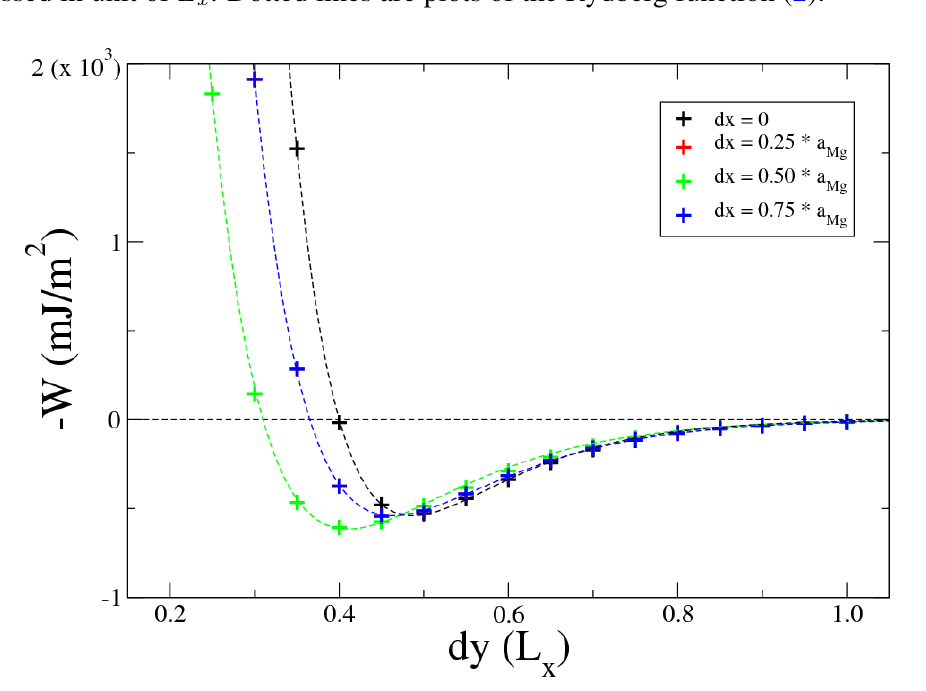
Figure 4. Work of adhesion for Mg-MgH interface with dz = 0 varying both dy and dx , dy 2 is expressed in unit of L . Dotted lines are plots of the Rydberg function (2). x